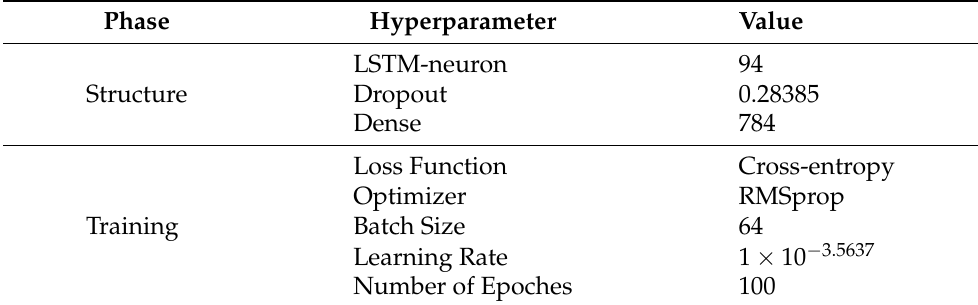
Figure 15. The accuracy of each model after optimization process. Table 3. The summarized hyperparameters of Vanilla LSTM network found by